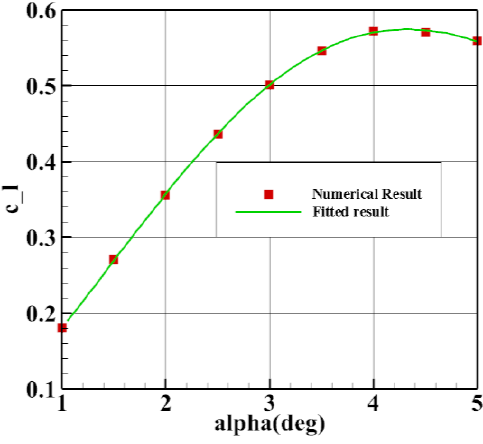
Figure 4. Lift coefficients vs. incidence angle. Figure 4. Lift coe ffi cients vs. incidence